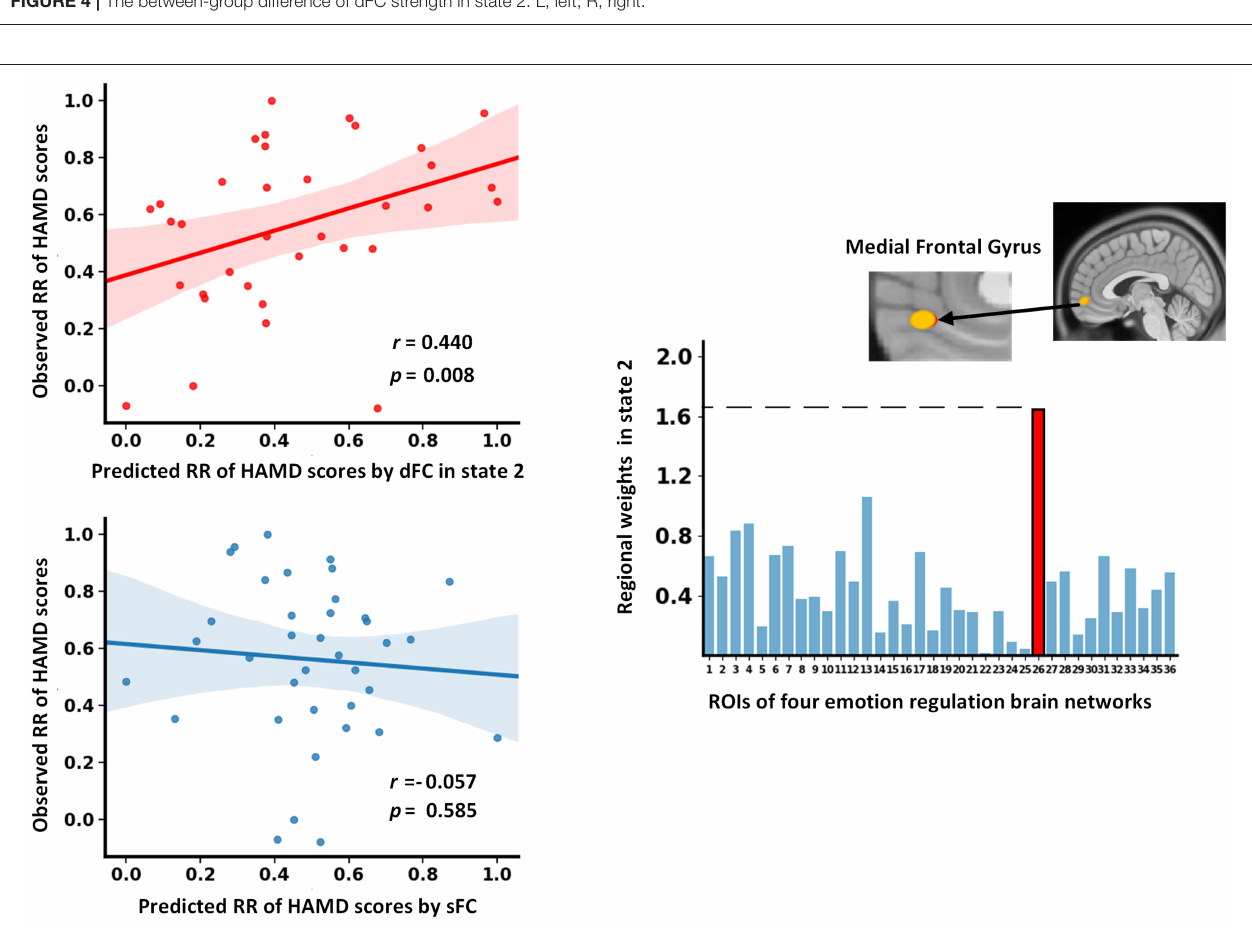
FIGURE 5 | The results of dFC strength and sFC as features to predict the RR of HAMD scores. dFC, dynamic functional connectivity; HAMD, Hamilton Depression Rating Scale; RR, reduction rate; sFC, static functional connectivity.